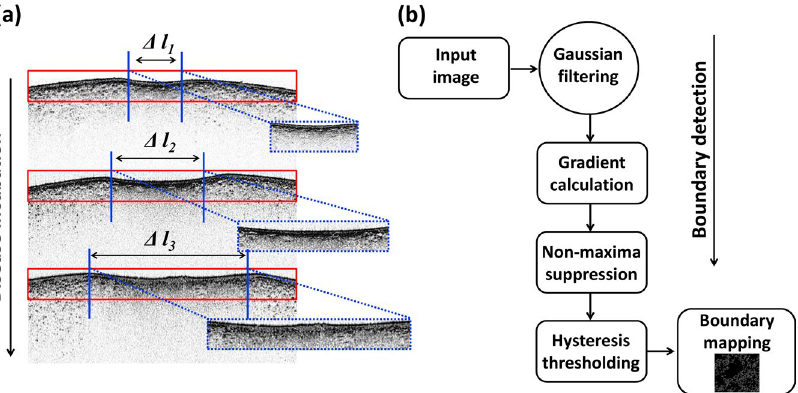
Figure 3. ( a ) The representation of the lateral direction expansion of the infected region as a function of the period of incubation. ( b ) Flow chart representing the main steps of the tissue boundary detection method. ( Δ l 1 ~ Δ l 3 illustrates the lateral direction expansion of the infected